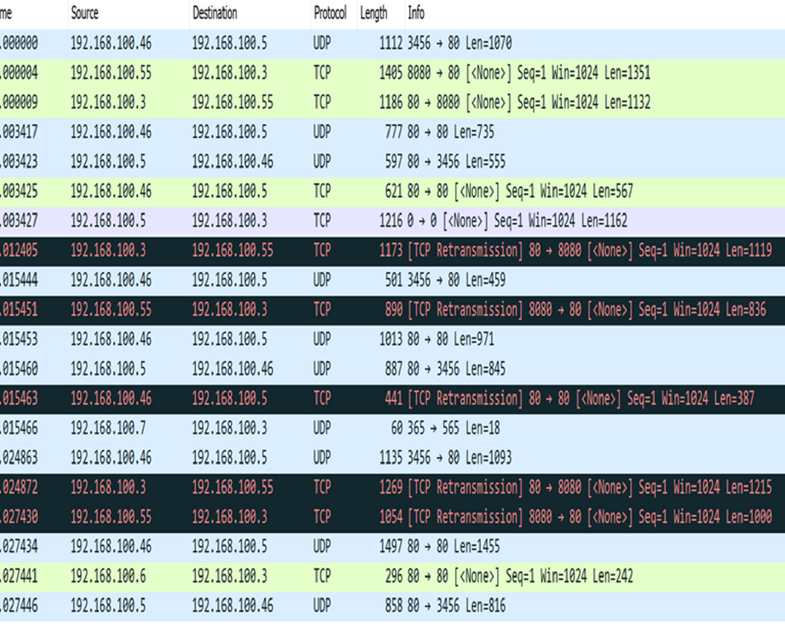
Figure 8. Model for distinguishing between IoT devices and non-IoT devices.